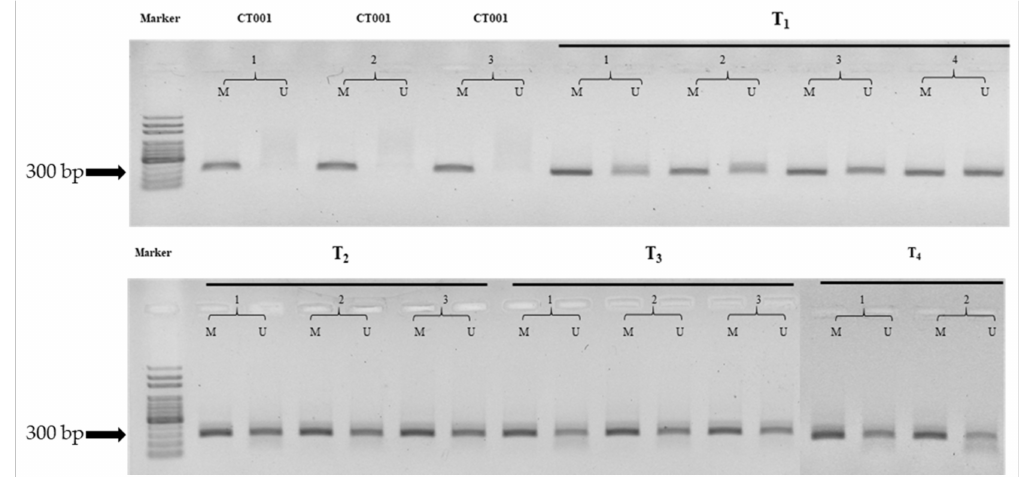
Figure 4. Methylation-specific PCR (MSP) analysis of TCD8 in the non-transgenic and transgenic lines. MSP was conducted to examine the methylation status of the three CT001, four T 1 (IGA7), three T 2 (IGA74), three T 3 (IGA743) and two T 4 (IGA7434) lines. M primer set amplified the methylated DNA with 288 bp and the U primer set amplified the unmethylated DNA with 290 bp. CT001, inbred line; T 1 , T 2 , T 3 , and T 4 , transgenic lines of IGA. M, methylated PCR products; U, unmethylated PCR